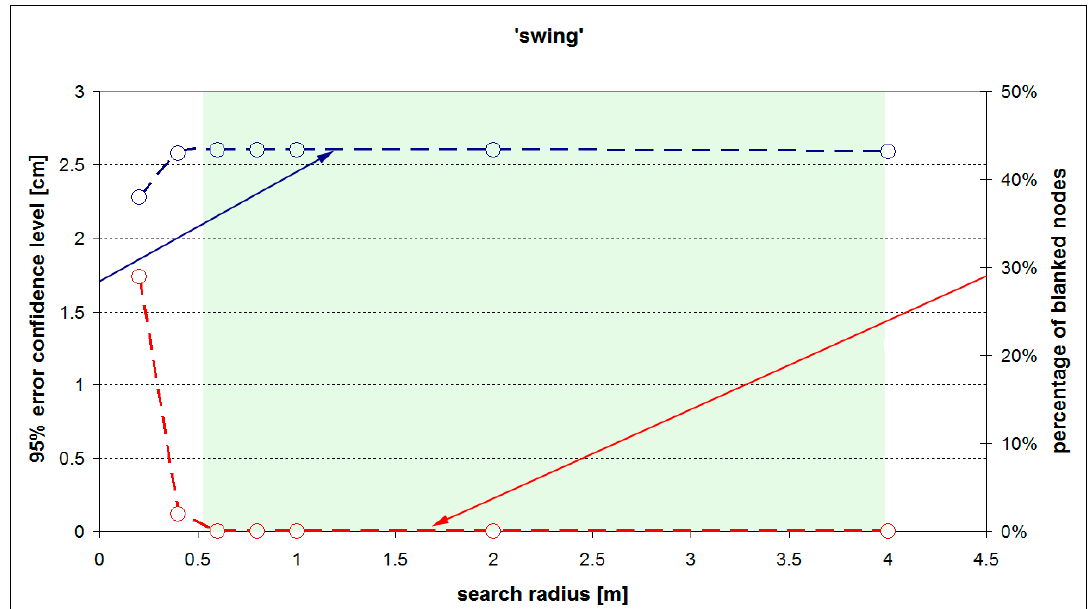
Figure 4. The results for the ‘swinging’ surface with different search radius values.